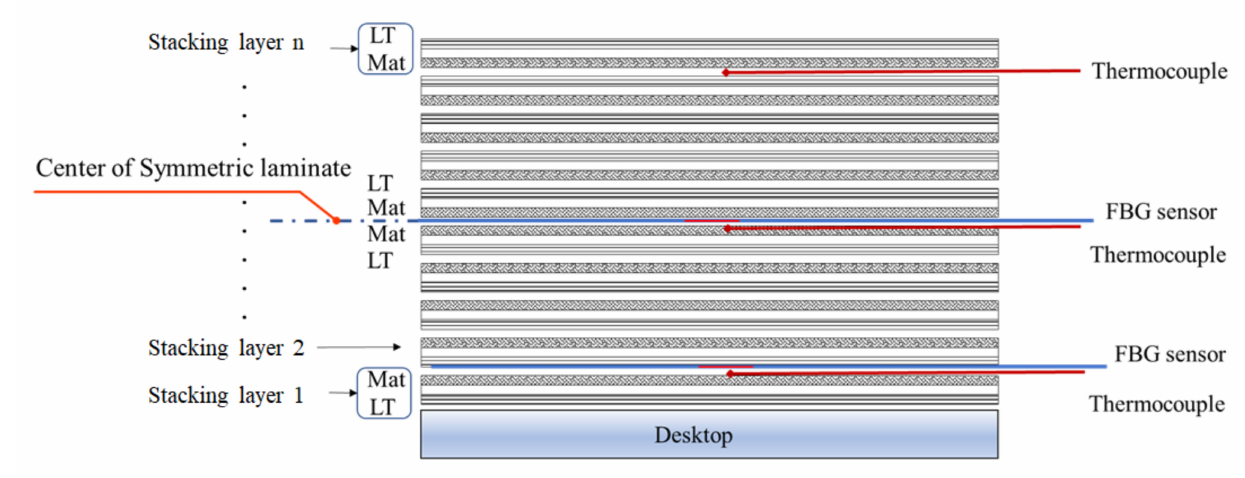
Figure 5. Symmetrical stacking sequence and sensor placement.